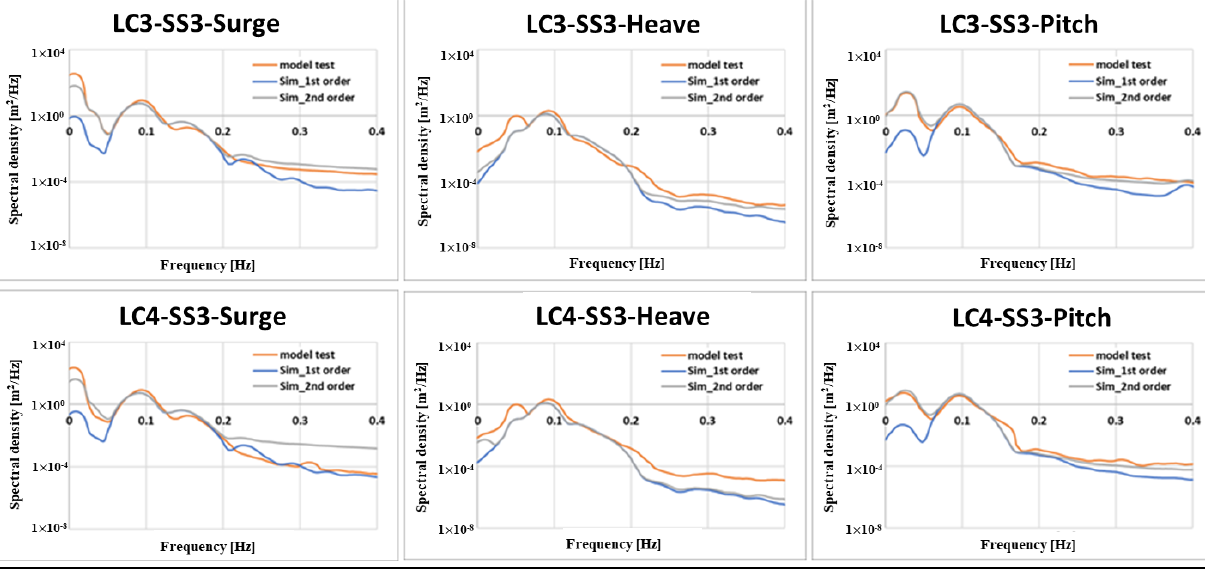
Figure 15. Sea state3: LC3 and LC4 result under irregular waves.